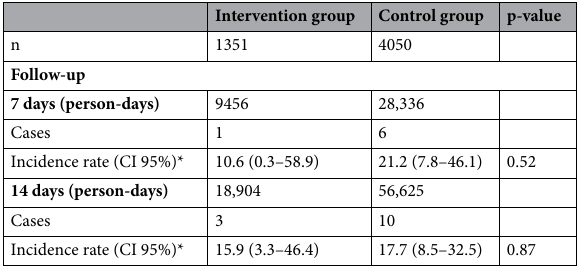
Table 2. Incidence rates of SARS-CoV-2 infection by group at 7 and 14 days of follow-up, Catalonia, (n = 5401). *Cases per 100,000 person-days.